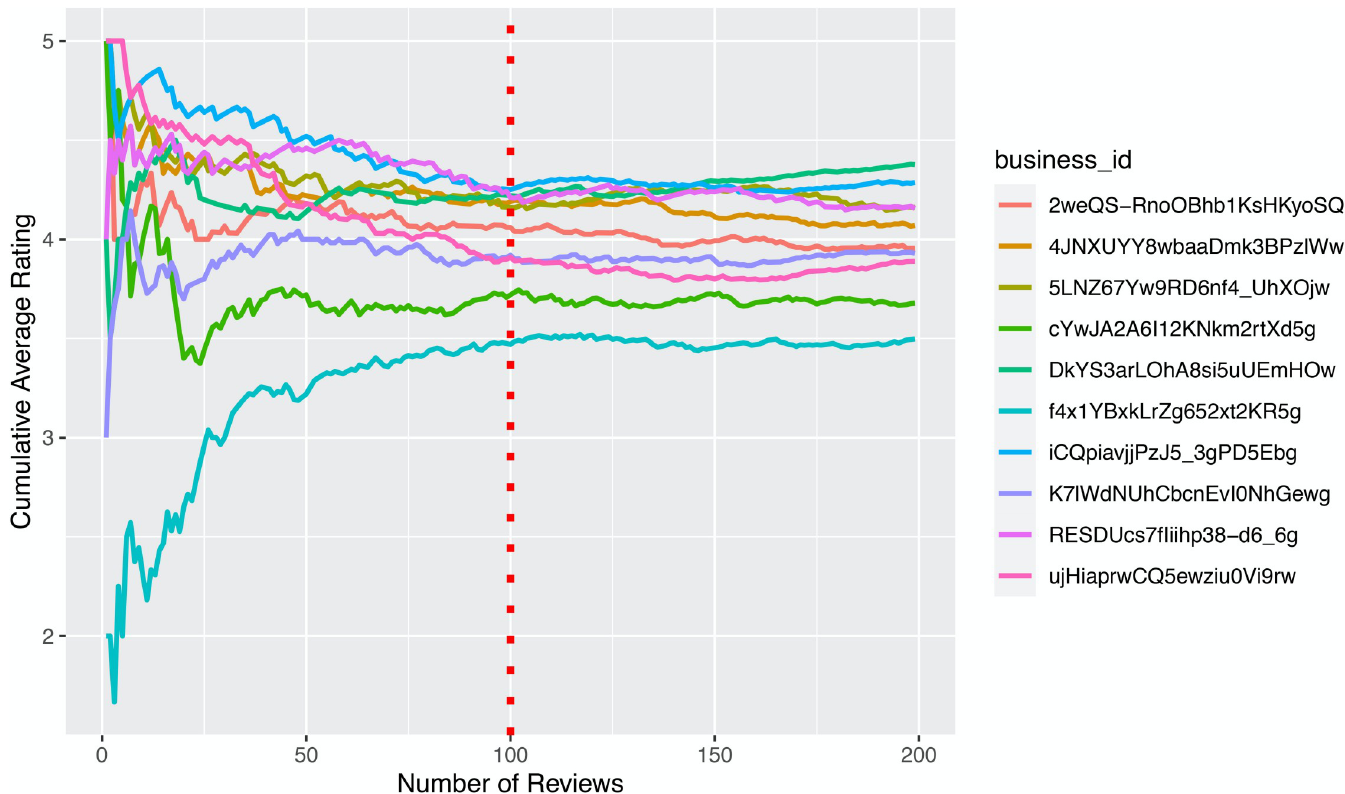
Fig 1. Average ratings stabilize with review volume (first 200 reviews). The cumulative average rating by the number of reviews from the 10 restaurants with most reviews in our dataset. After receiving 100 reviews, the average ratings of the 10 restaurants tend to